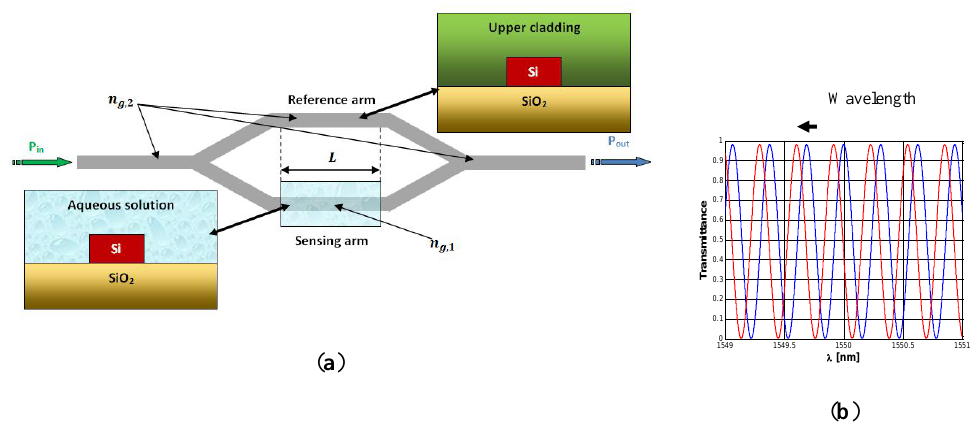
Figure 10. ( a ) Sketch of a MZI sensor; ( b ) Typical transmittance of the MZI sensor at rest (blue curve) and in presence of the analyte (red